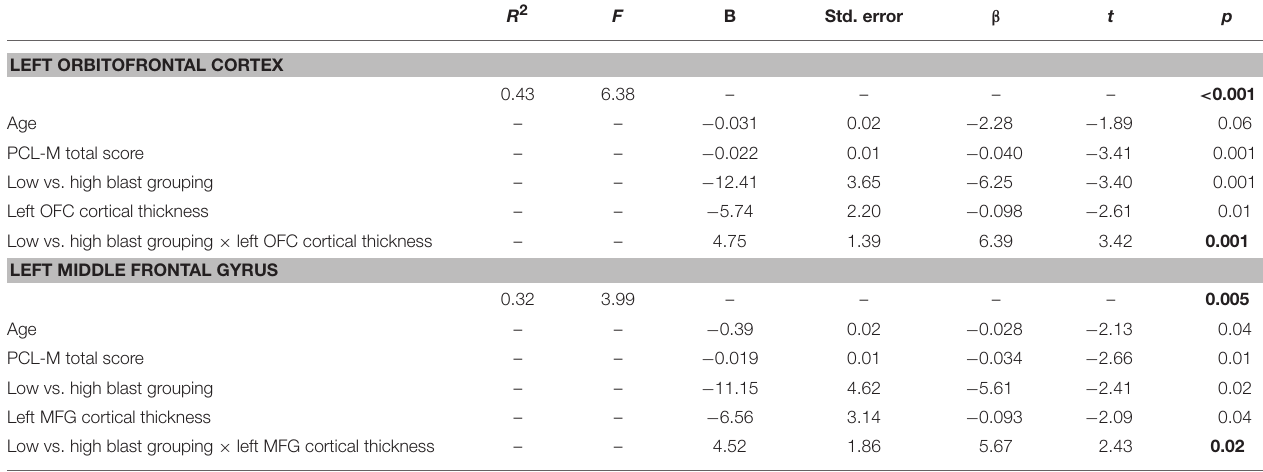
TABLE 2 | Multiple linear regression models for cortical thickness × blast exposure grouping (mTBI + BE high vs. mTBI + BE low) on executive functions factor.